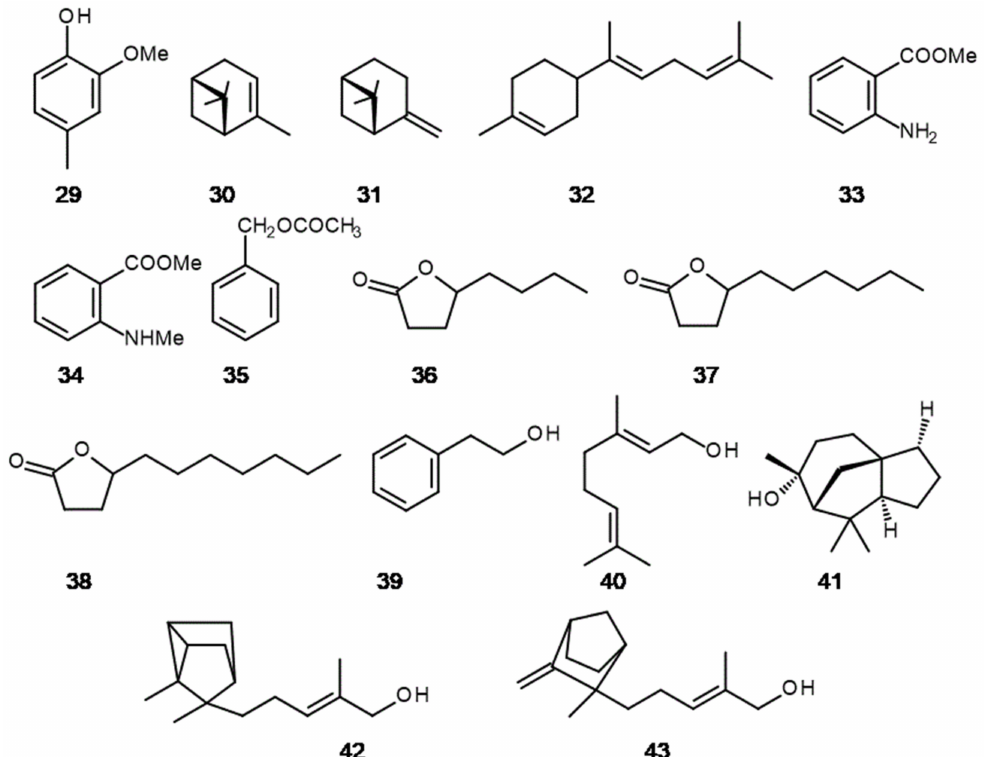
Figure 6. Natural isolates applied as food additives or perfume ingredients: ( 29 ) 4-methylguaiacol, ( 30 ) α -pinene, ( 31 ) β - pinene, ( 32 ) α -bisabolene, ( 33 ) methyl anthranilate, ( 34 ) methyl N -methylanthranilate, ( 35 ) benzyl acetate, ( 36 ) γ -octalactone, ( 37 ) γ -decalactone, ( 38 ) γ -undecalactone, ( 39 ) 2-phenylethanol, ( 40 ) geraniol, ( 41 ) cedrol, ( 42 ) α -santanol, ( 43 ) β